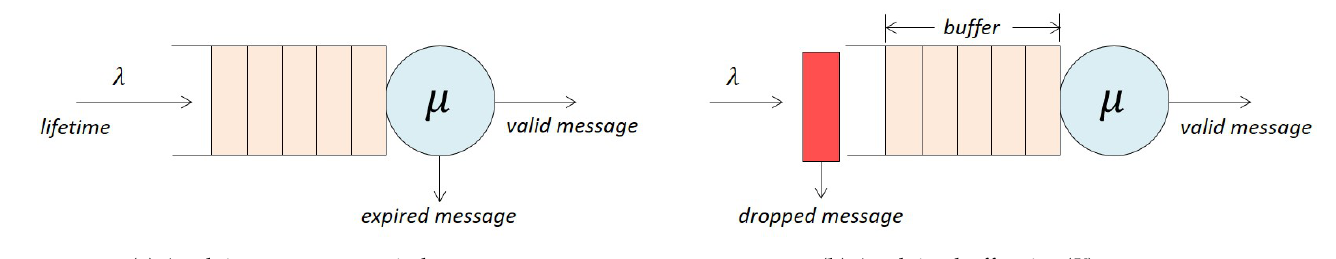
Figure 4. Queues with event expirations and finite